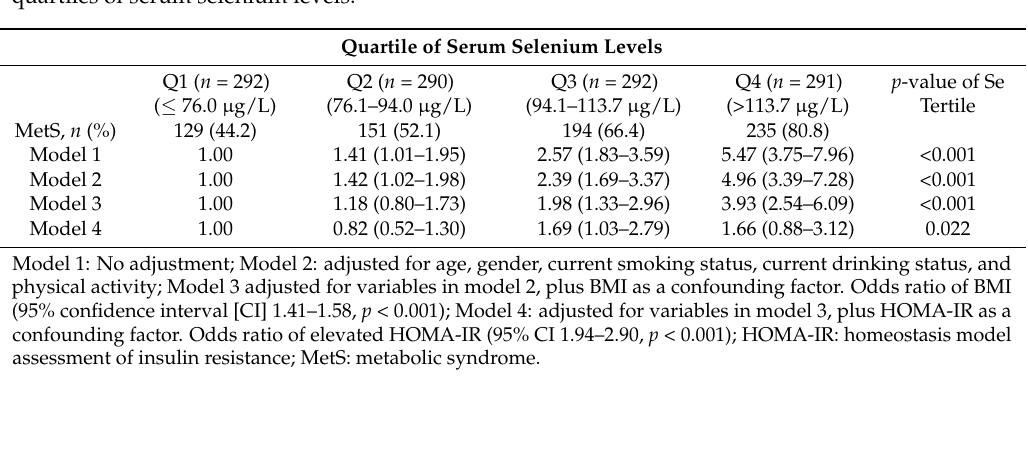
Table 2. Odds ratios (ORs) of having MetS derived from multiple logistic regression analyses in quartiles of serum selenium